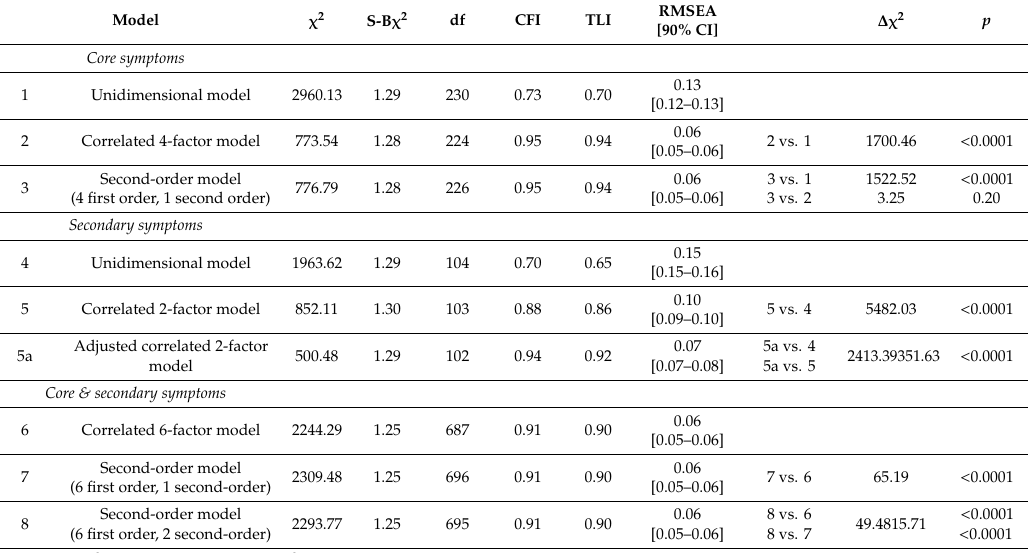
Table 1. Model fit indices for the di ff erent BAT